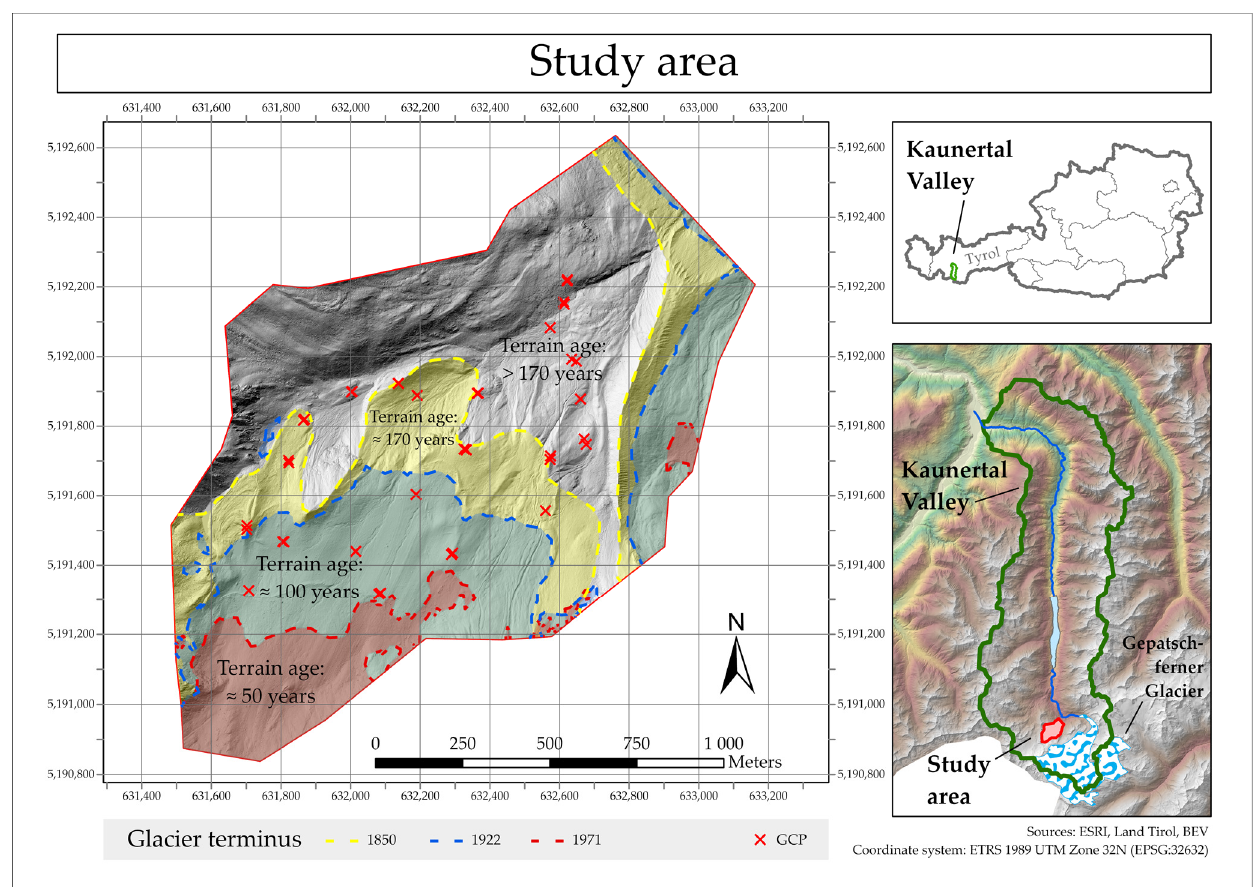
Figure 1. Study area. Overview and detailed map of the study area with glacier terminus lines and successional stages. The study area is located in the federal state of Tyrol in Austria.